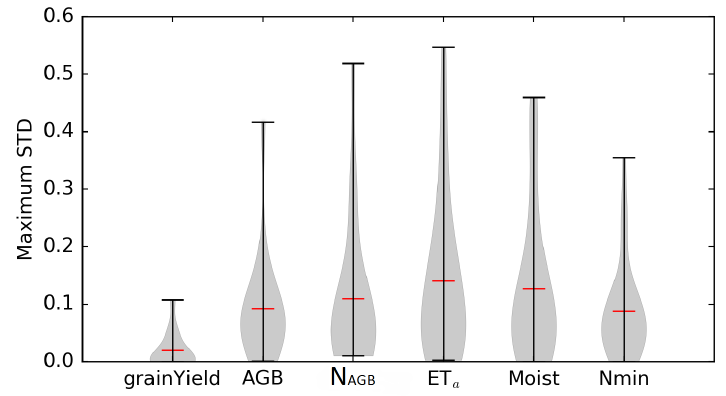
Figure 8. Variations in the main effects caused by site-specific differences in soil or weather conditions. The violin plots aggregate the maximum standard deviations of the daily S i values for all sites and each analyzed